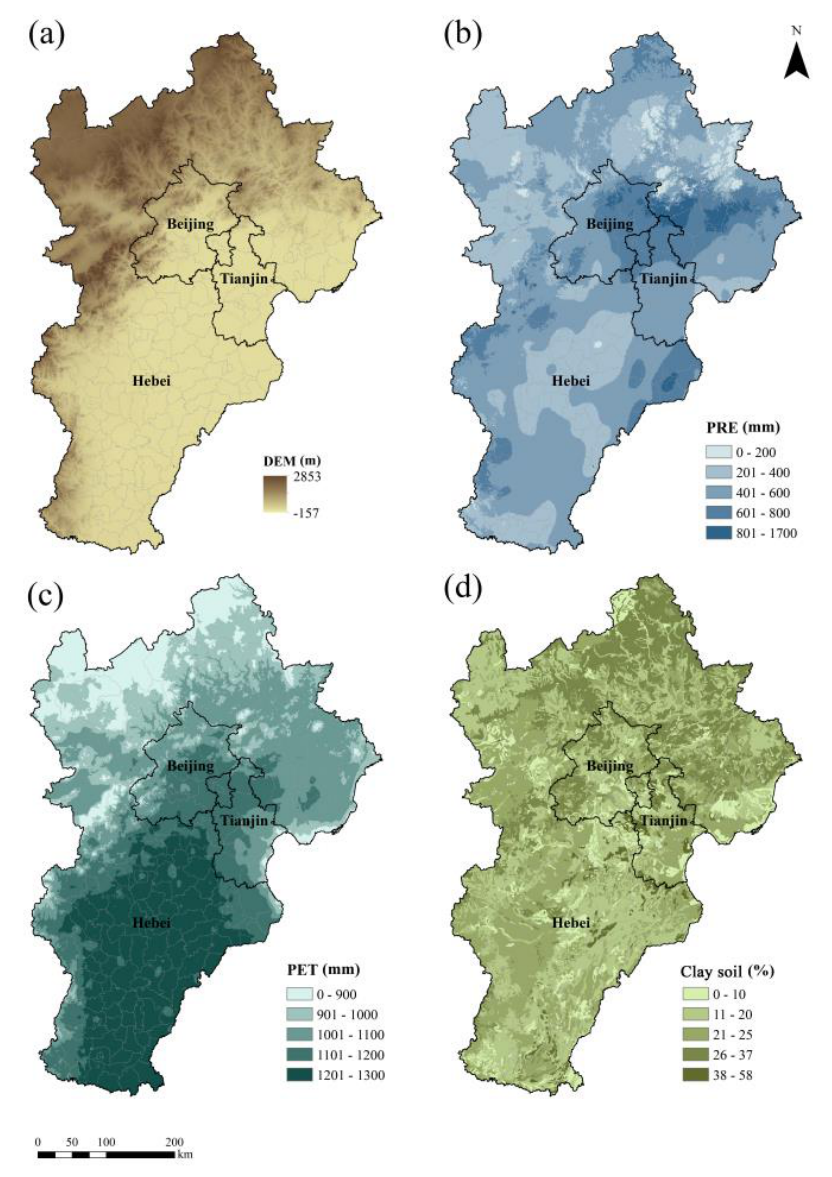
Figure 2. Data examples used in the study: ( a ) digital elevation model (DEM), ( b ) precipitation (PRE), ( c ) potential evapotranspiration (PET), ( d ) clay soil percentage.